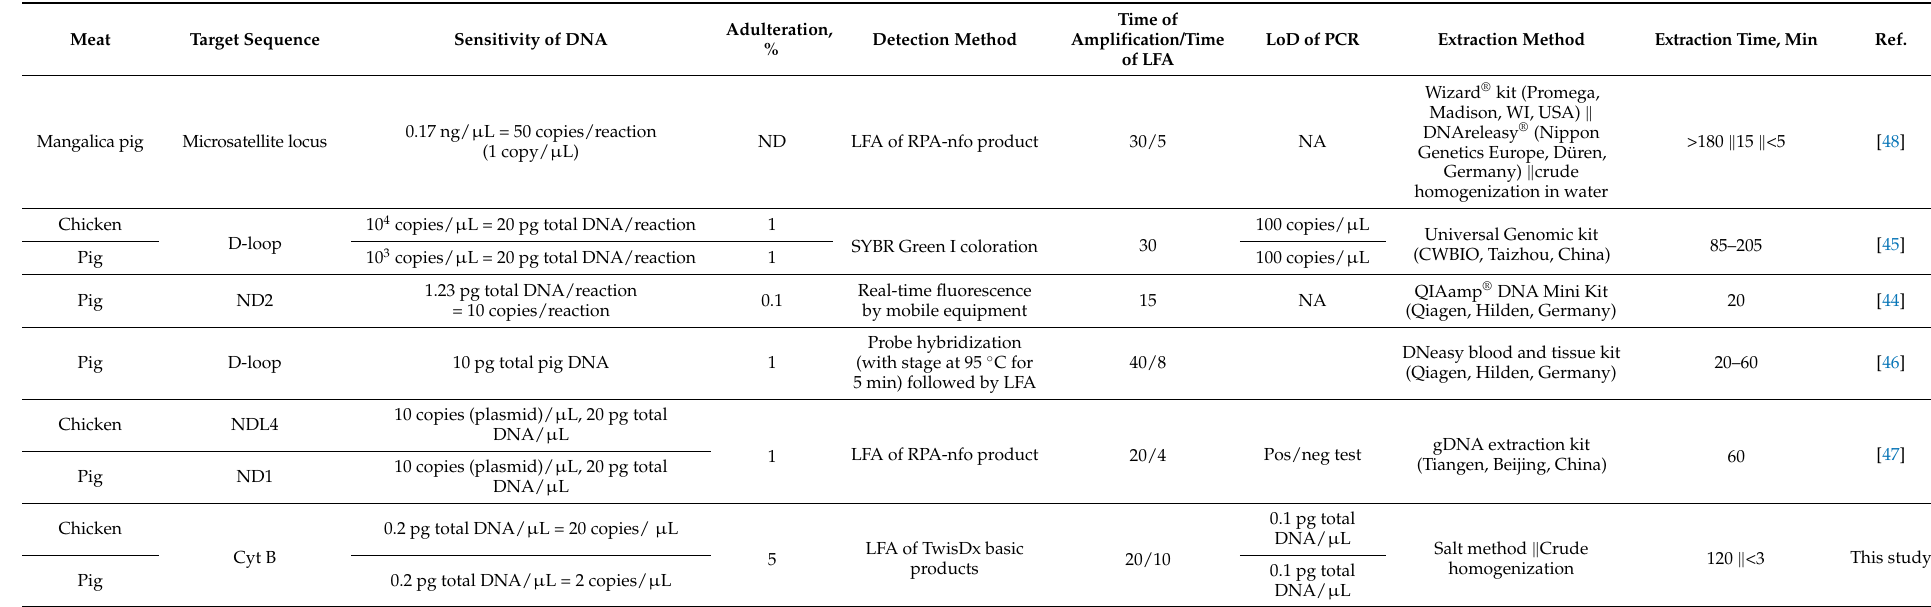
Table 3. Comparison of RPA-based tests for chicken and pig